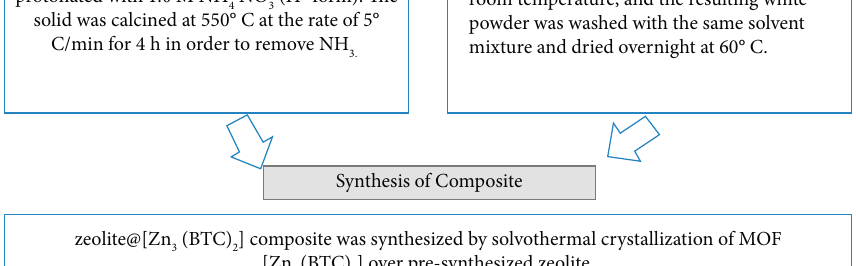
Figure 7: Solvothermal synthesis method of zeolite@ [Zn